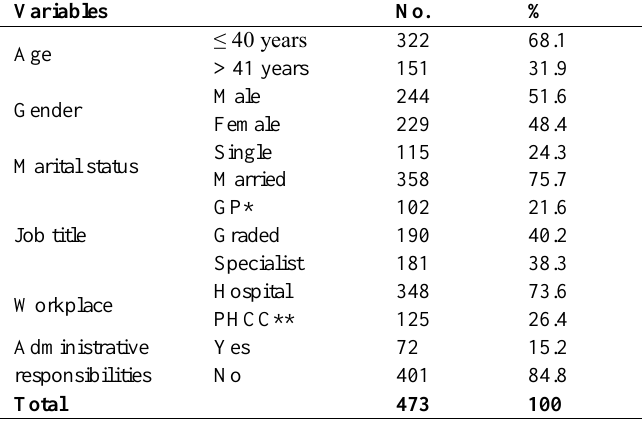
Table 1: Socio-demographic characteristics of the study sample Variables